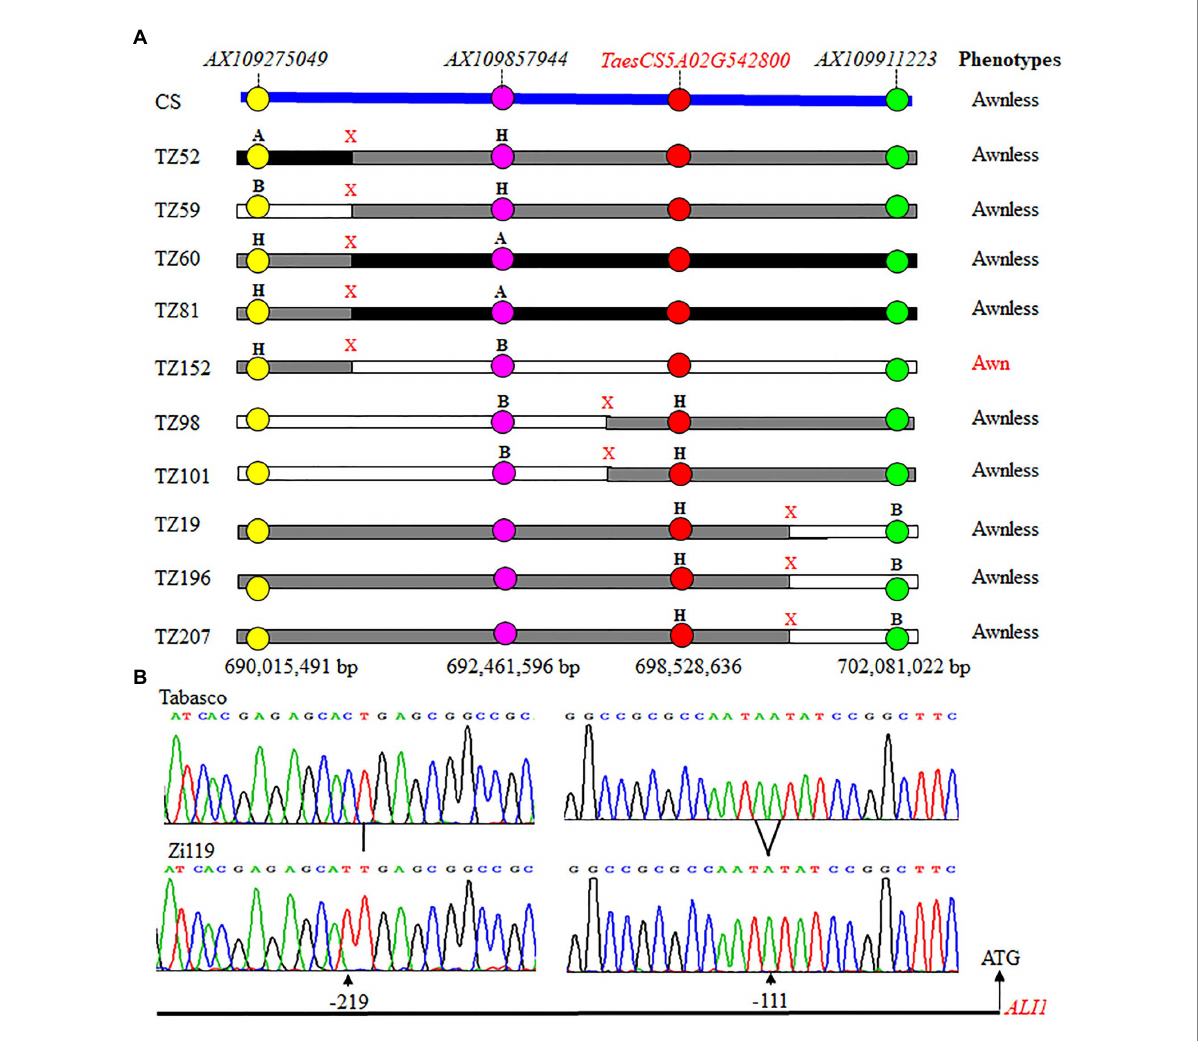
FIGURE 4 Genotypes and phenotypes of 10 recombinant plants that have crossovers at the ALI-A1 locus. (A) Physical locations of 10 crossovers that occurred at the ALI-A1 locus. Markers mapped chromosome arm 5AL that are indicated in different colors are arranged based on the sequences of Chinese Spring (CS). ALI-A1 is annotated TaesCS5A02G542800 . “A” is the Tabasco allele, “B” for the Zi119 allele, and “H” for the heterozygote. “X” indicates a crossover detected between two neighboring markers. Phenotype of each recombinant plant was of awn or awnless. (B) Comparison of promoter sequences between the Tabasco allele and the Zi119